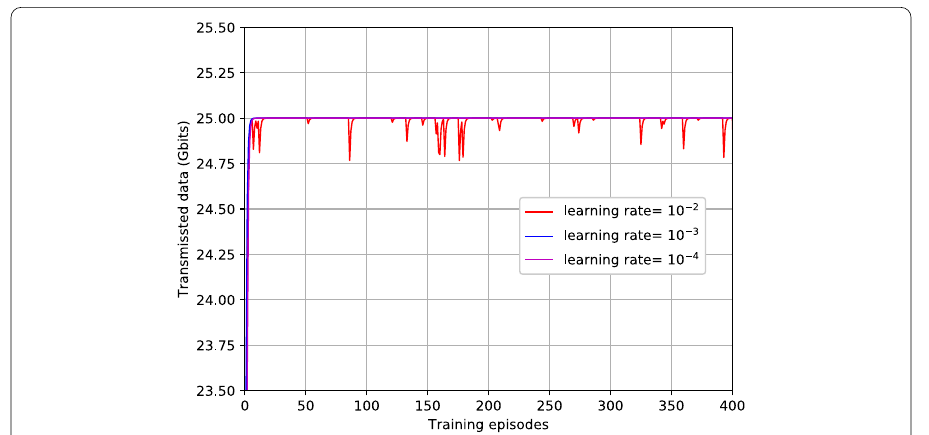
Fig. 8 Transmitted data with different learning rate